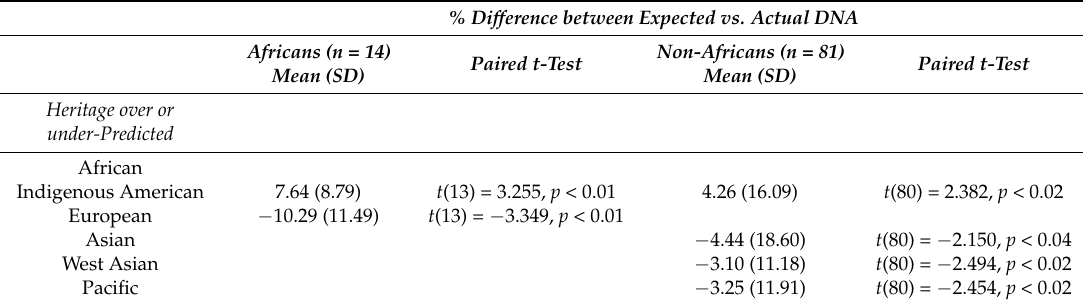
Table 2. Summary table on over- or under-prediction of heritage among Africans vs. Non-Africans. % Difference between Expected vs. Actual DNA Africans (n = 14) Non-Africans (n = 81) Paired t-Test Paired Mean (SD) Mean (SD)